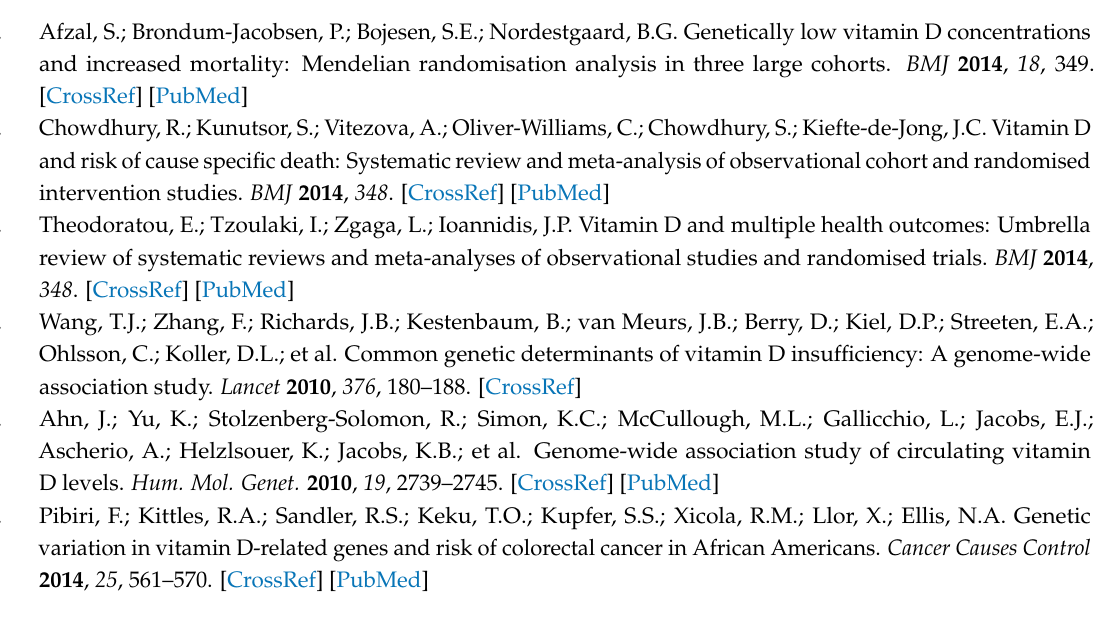
Table S1: Minor allele frequencies of circulating 25OHD SNPs, Table S2: Concentration of 25OHD according to genotypes used as instrumental variables in GRS (DHCR7/CYP2R1/GC) adjusted for potential confounders individually Table S3: Concentration of 25OHD according to genotypes used as instrumental variables in GRS (DHCR7/CYP2R1/GC), Table S4: Concentration of 25-hydrovyvitamin D mean (SD) nmol/L by genotype copies of risk allele in WGHS subgroup ( n = 1782), Table S5: Cox proportional hazards for incident cancer and mortality by circulating vitamin D SNP per allele associated with increase in 25-hydroxyvitamin D, Table S6: Mean 25-hydroxyvitamin D level nmol/L for each value of GRS in the case/control cohort ( n = 1782), Table S7: Mean 25OHD level nmol/L for each category of GRS in the case/control cohort ( n = 1782), Table S8: Cox proportional hazards for cancer and mortality for Genetic Risk Score of alleles associated with increase in circulating 25-hydroxyvitamin D (continuous and categorical) additionally adjusted for BMI, Table S9: Cox proportional Hazards for Cancer and Mortality for Genetic Risk Score without vitamin D binding protein (GC) alleles associated with increase in circulating 25OHD (continuous and